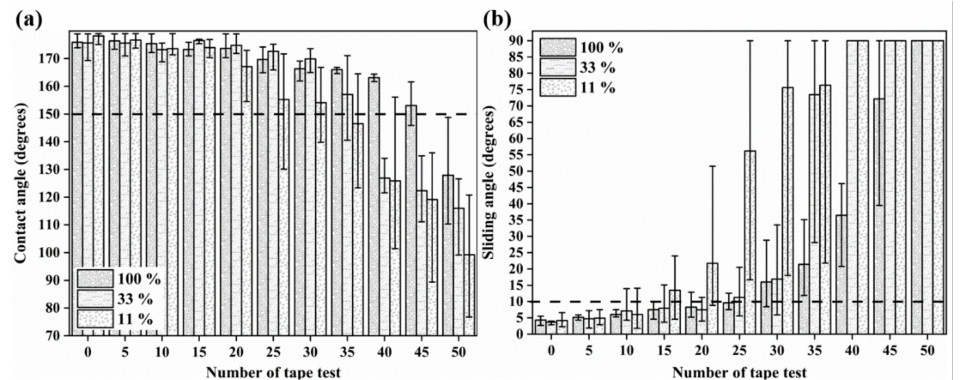
Figure 8. Results of the scotch tape test of the fabricated superhydrophobic coated films with different relative SNP weight ratios of 100%, 33%, and 11%: ( a ) CA and ( b )